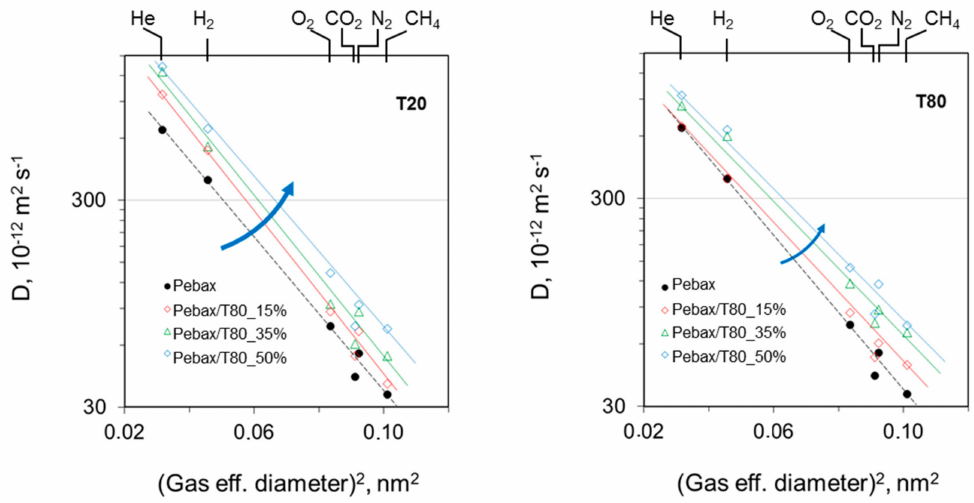
Figure 8. Correlation of the di ff usion coe ffi cients with the squared gas molecular size. The arrows indicate the increase in polysorbate